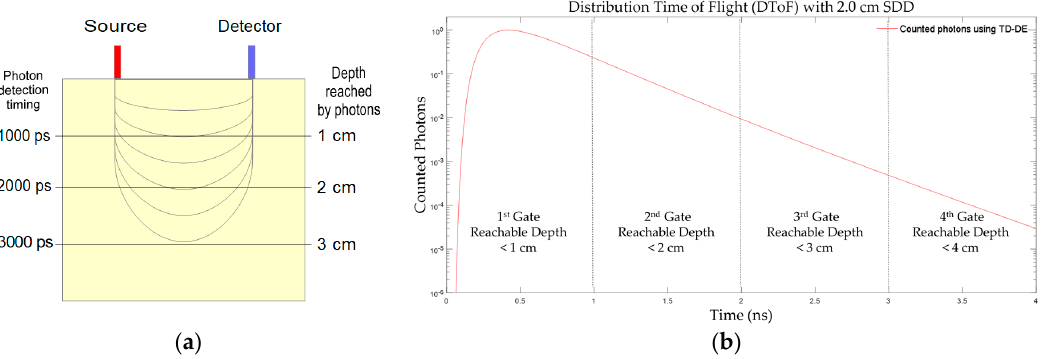
Figure 2. Photons reached areas within the target for each time gate window with different delays. ( a ) An illustration of increasing the reachable depths for photons detected at late gates. ( b ) The positions of gates on the DToF histogram and the possible reachable depth of detected photons during each gate.